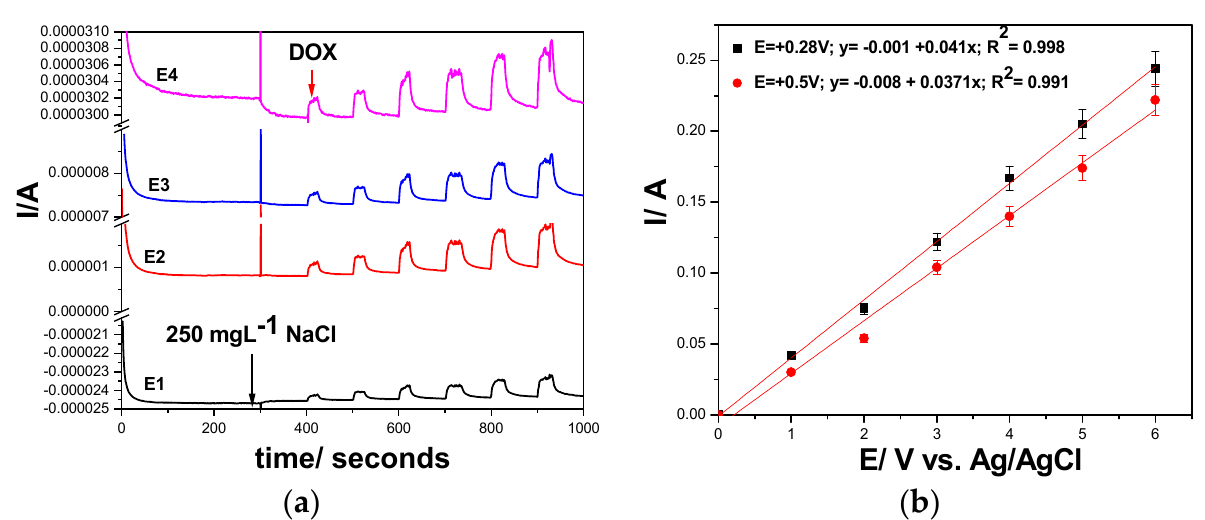
Figure 13. ( a ) Multiple-pulsed amperograms recorded at Cu/GRQD/CNT electrode in 0.1 M NaOH supporting electrolyte and consecutively and continuously adding 1 mg · L − 1 DOX, recorded at E1 = − 0.5 V/Ag/AgCl, E2 = +0.28 V/Ag/AgCl, E3 = +0.6 V/Ag/AgCl, and E4 = +1.25 V/Ag/AgCl in the presence of 250 mg · L − 1 NaCl; ( b ) Calibration plots of the currents recorded at: E= +0.28 V/ Ag/ AgCl, and E= +0.6 V/Ag/AgCl, versus doxorubicin concentrations.